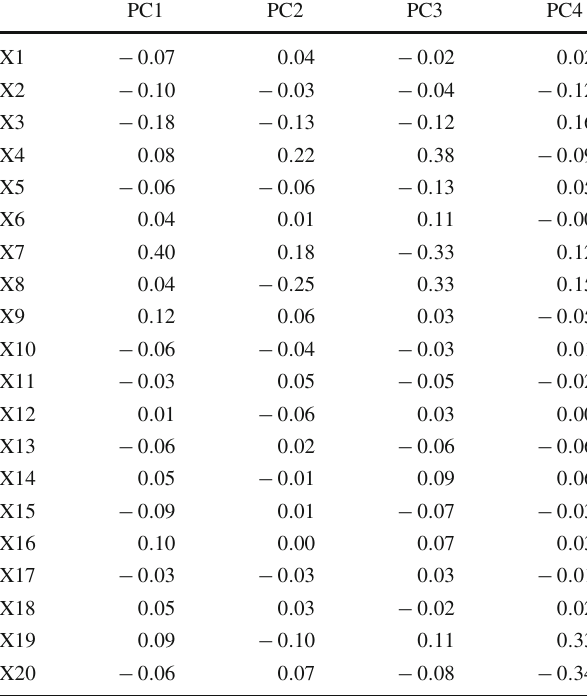
Table 7 Rotation onto first four PCs found for the jet